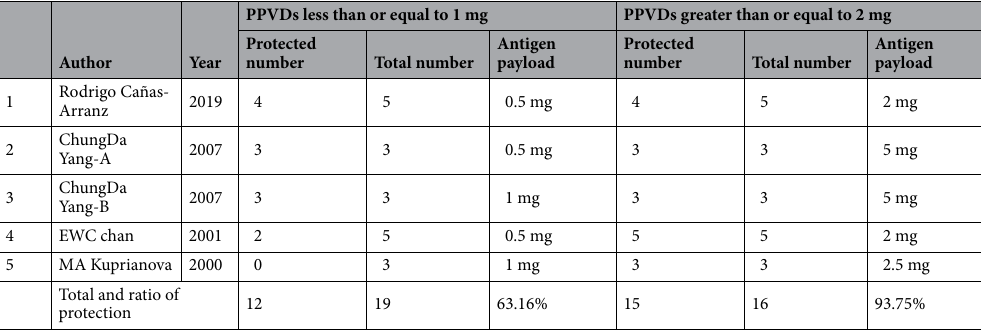
Table 4. Number of animals protected by PPVDs less than or equal to 1 mg group and PPVDs greater than or equal to 2 mg group.